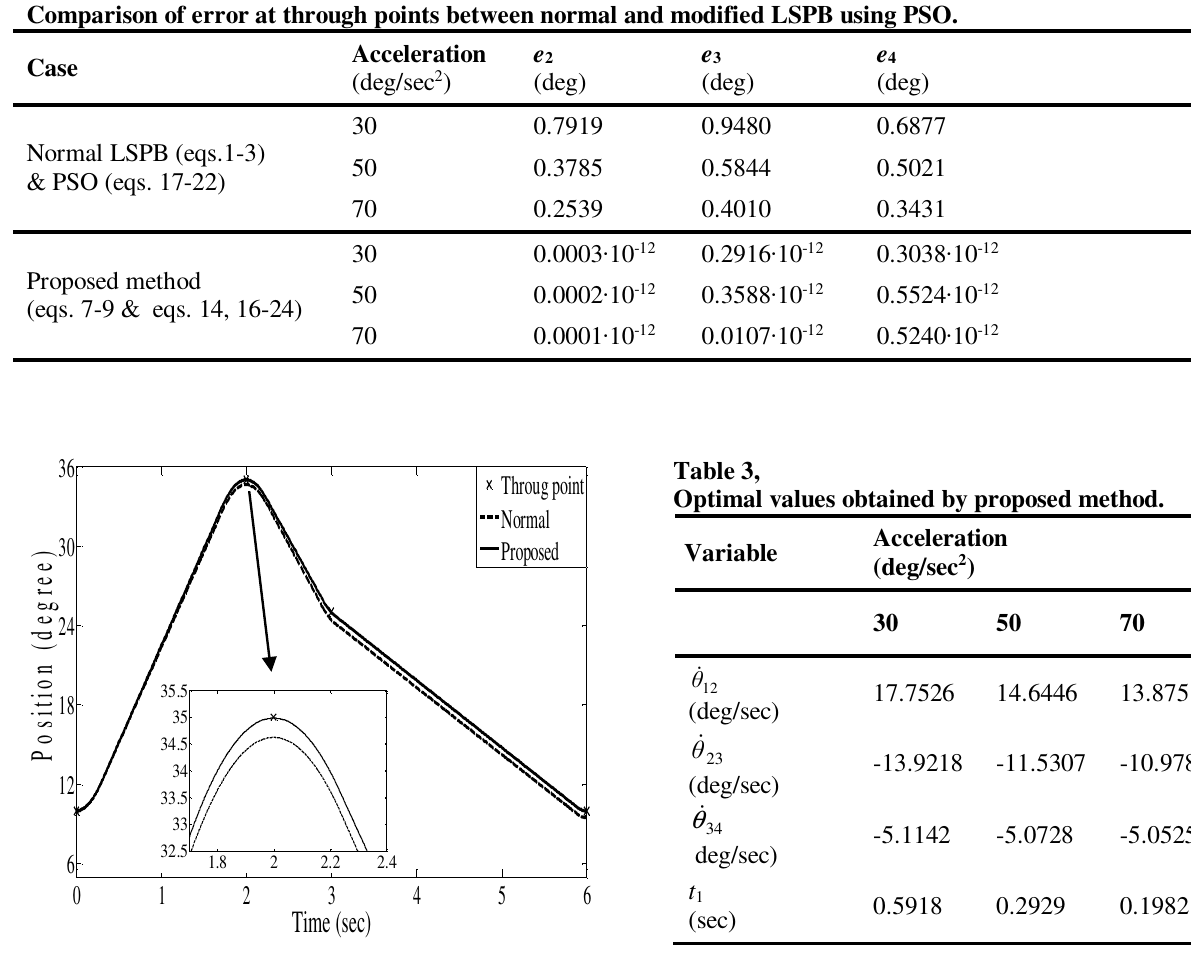
Fig. 5. Comparison between normal and modified LSPB trajectory using PSO.